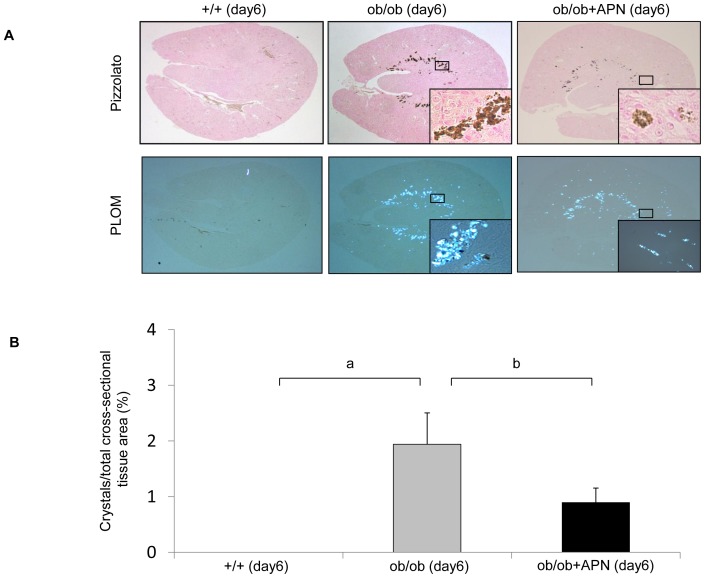
Detection and quantification of calcium oxalate kidney crystal formation.A. Kidney sections of wild type (+/+), obesity (ob/ob), and adiponectin-treated ob/ob (ob/ob+APN) mice at day 6. The upper images show calcium oxalate crystal deposits in Pizzolato-stained sections. The lower images show non-stained sections observed by polarized light optical microphotography (PLOM). Magnification is ×20 (in box: ×400). B. Quantification of kidney crystals in +/+, ob/ob, and ob/ob+APN mice. Data are indicated as the mean ± SD. a; p = 0.0004, b; p = 0.005.